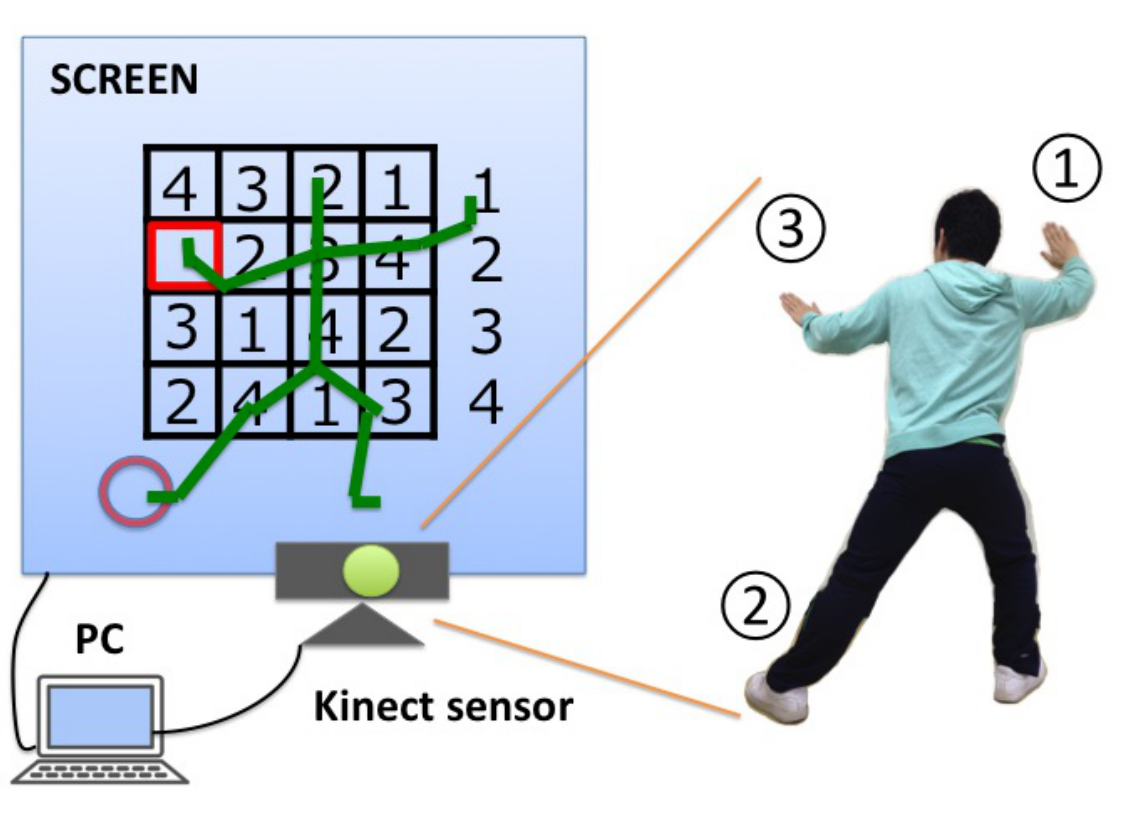
Figure 1. View of the Dual-Task Tai Chi (DTTC)